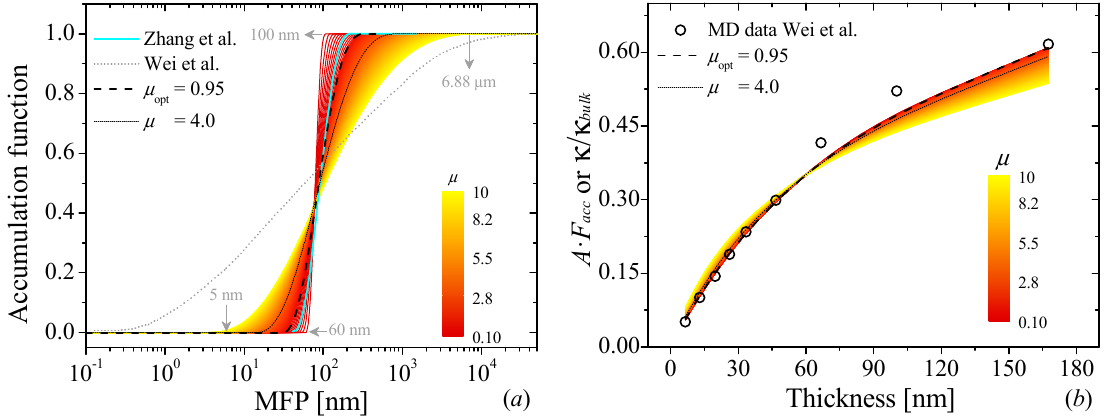
Figure 3. ( a ) Phonon mean free path distribution of the accumulation function reconstructed for different values of µ (0.1–10) using the FS cross-plane suppression function and the simulated κ made by Wei et al. [14]. The black-dashed and black-dotted lines represent reconstructions obtained by using an optimum (0.95) and large (4.0) µ -value, respectively. The cyan solid and grey dotted line represent the MFP reconstruction obtained by Zhang et al. [16] and Wei et al. [14] ( b ) Thermal conductivity normalized to the bulk value and/or A · F acc product as function of graphite thickness. The open dots represent the simulated thermal conductivity (“experimental data”). Heat-like lines correspond to different A · F acc for µ -values in a range of 0.1 < µ < 10.